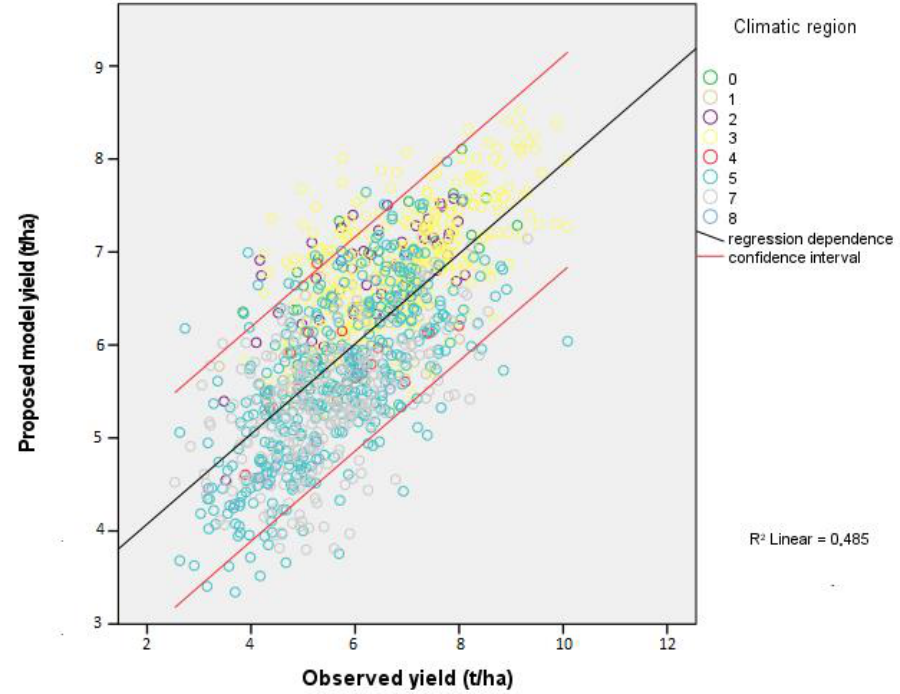
Figure 2. Comparison of winter wheat yields and yield prediction using the production function [38].